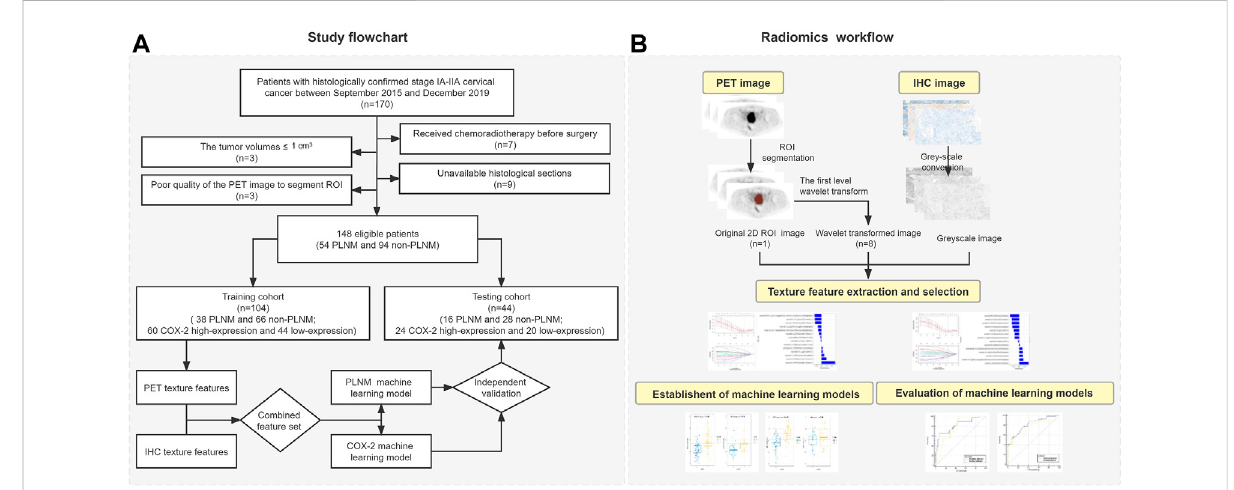
FIGURE 1 Study fl owchart and radiomics work fl ow. (A) Study fl owchart. (B) Radiomics work fl